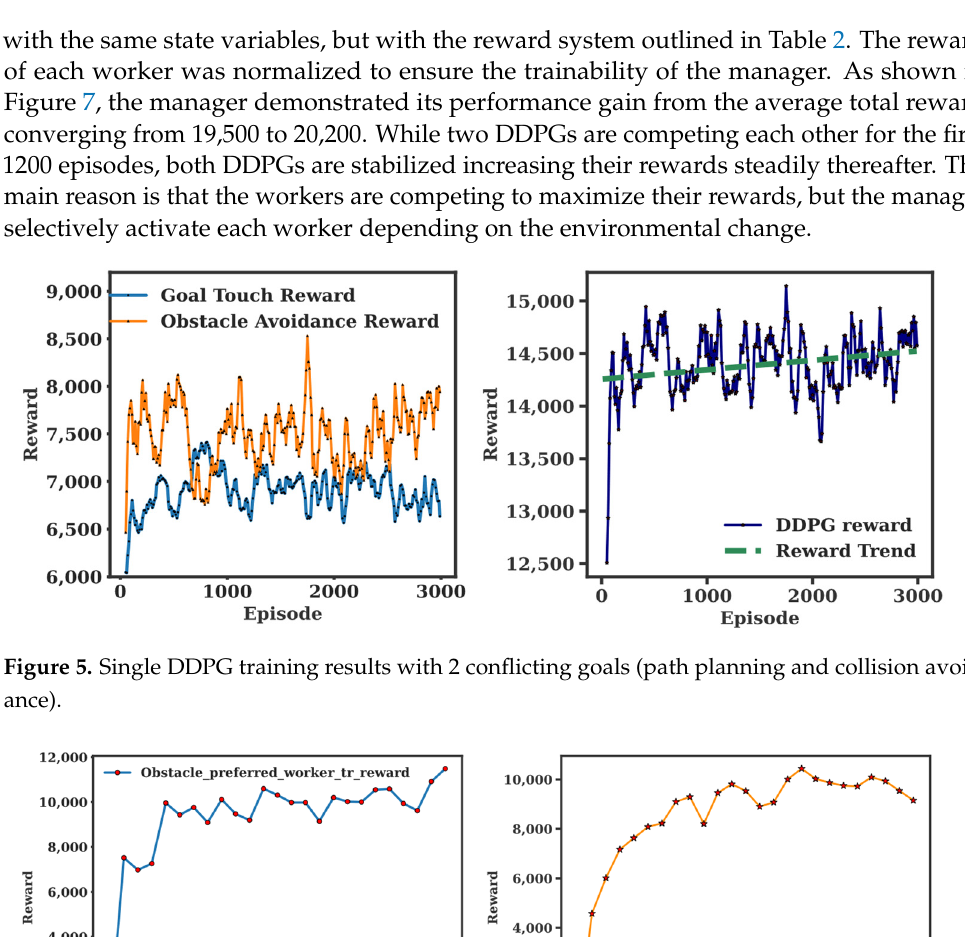
Figure 6. Individual worker training: rewards of obstacle avoidance worker